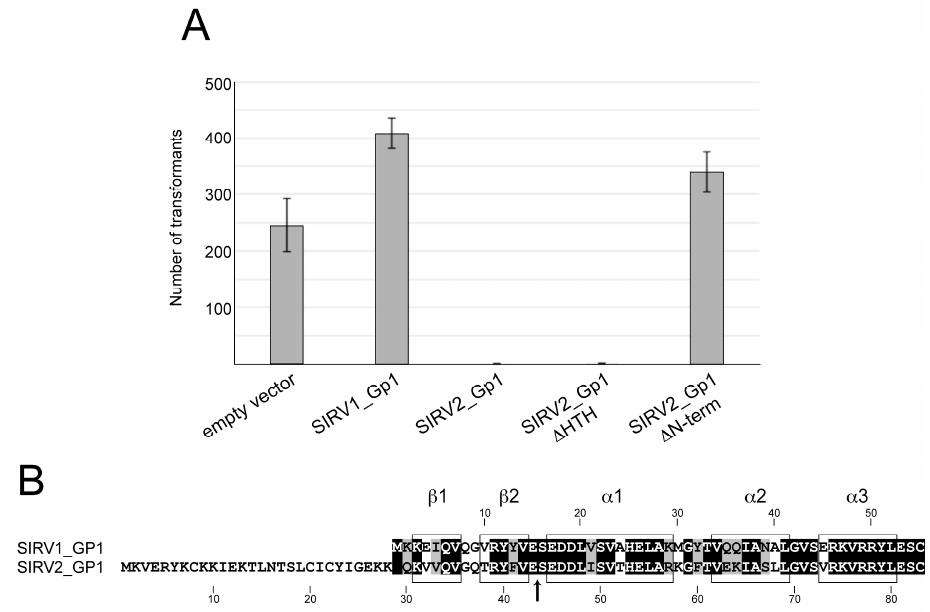
Figure 3. Toxicity effects of different Gp1 variants. ( A ) Transformation efficiencies of plasmid vectors harboring SIRV _ gp1 variants. Y-axis, number of transformants. An empty plasmid vector and plasmids containing SIRV1 _ gp1 , SIRV2 _ gp1 and truncations thereof were transformed into S. acidocaldarius and plated on selective medium. Colonies were counted after six days of incubation at 75 ◦ C. The average absolute number of colonies is shown in the y -axis. Gp1 ∆ HTH, Gp1 truncation mutant missing the helix-turn-helix (HTH) domain. Gp1 ∆ N-term, Gp1 truncation mutant lacking the 28 N-terminal amino acids. Error bars, standard deviation. ( B ) Amino acid sequence alignment of SIRV2_Gp1 and SIRV1_Gp1, with indication of the secondary structure elements of the SIRV1_Gp1 structure. Arrow indicates C-terminus of Gp1 ∆ HTH.